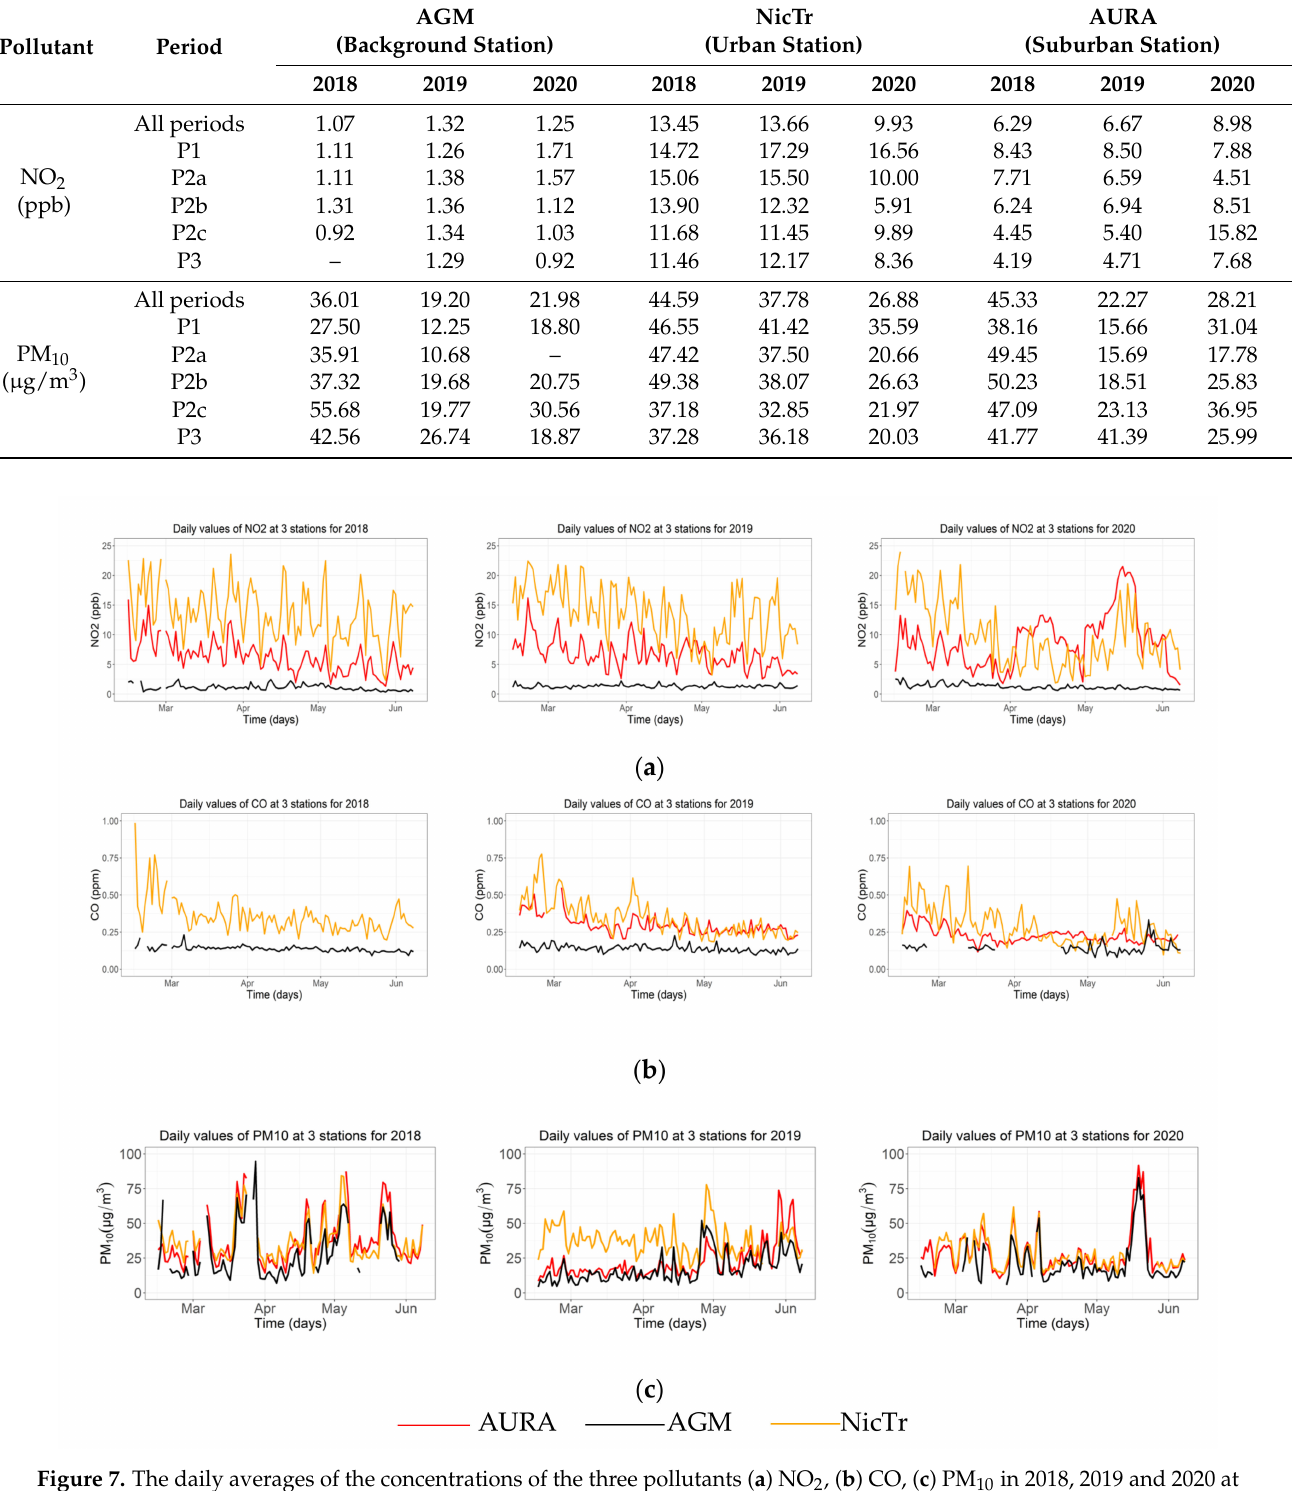
Table 6. The period averages for AGM, NicTr station and AURA station for 2018, 2019 and 2020.